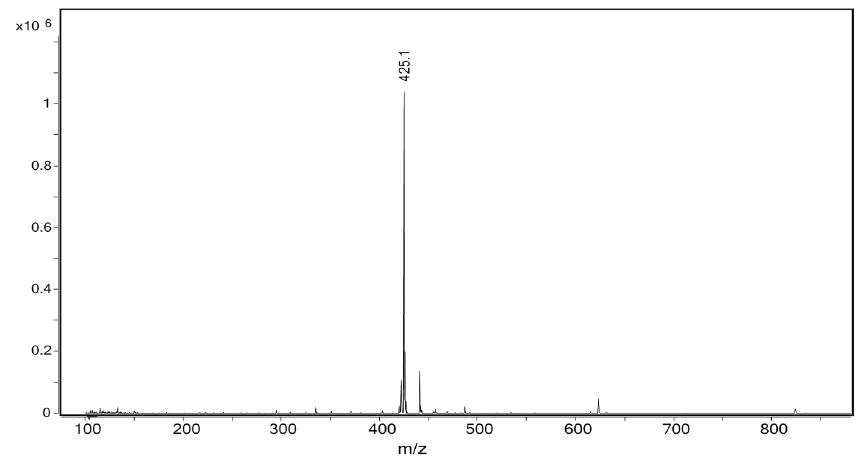
Figure 5. ESI-MS + spectrum of B6AG.